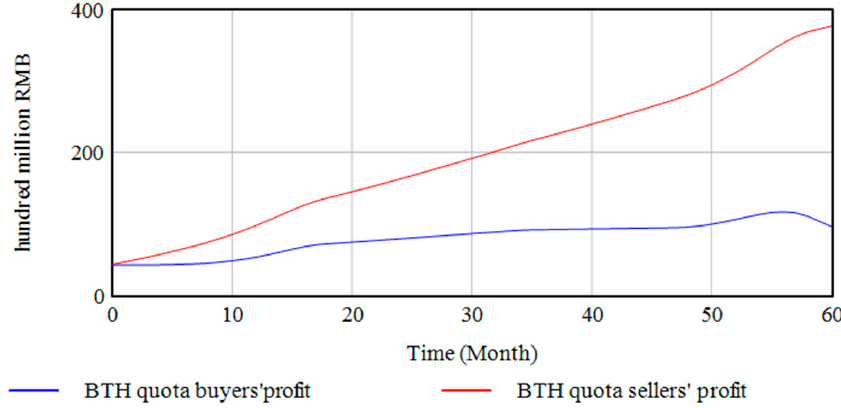
Figure 11. Trend of change in profits of thermal power generators.